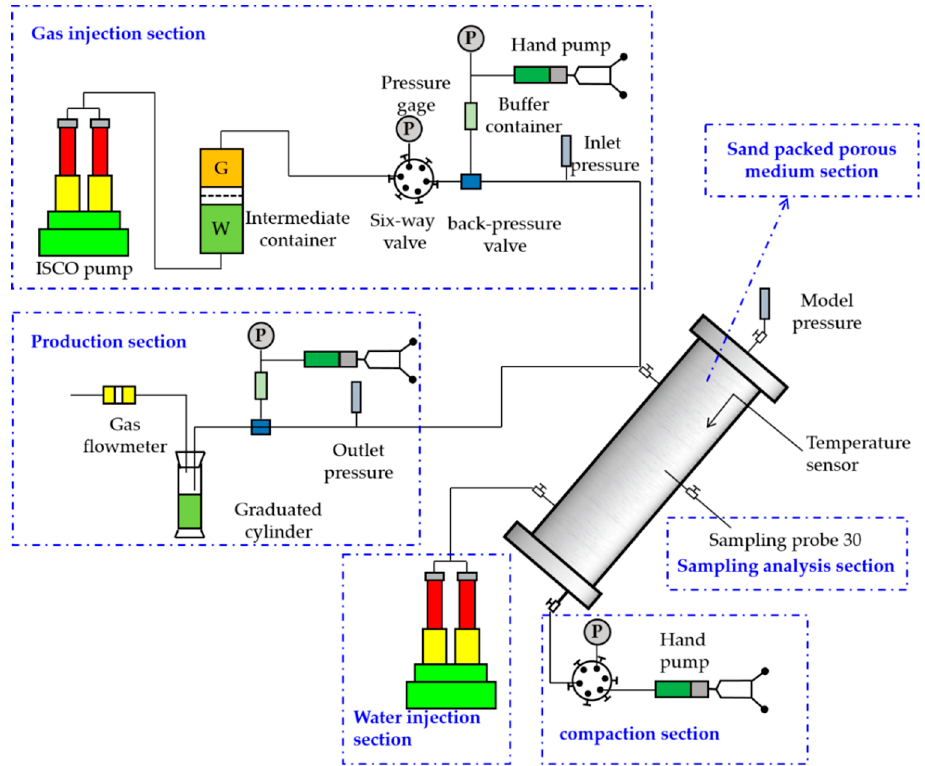
Figure 2. A schematic diagram of the experimental setup for assistant gas–oil countercurrent production.